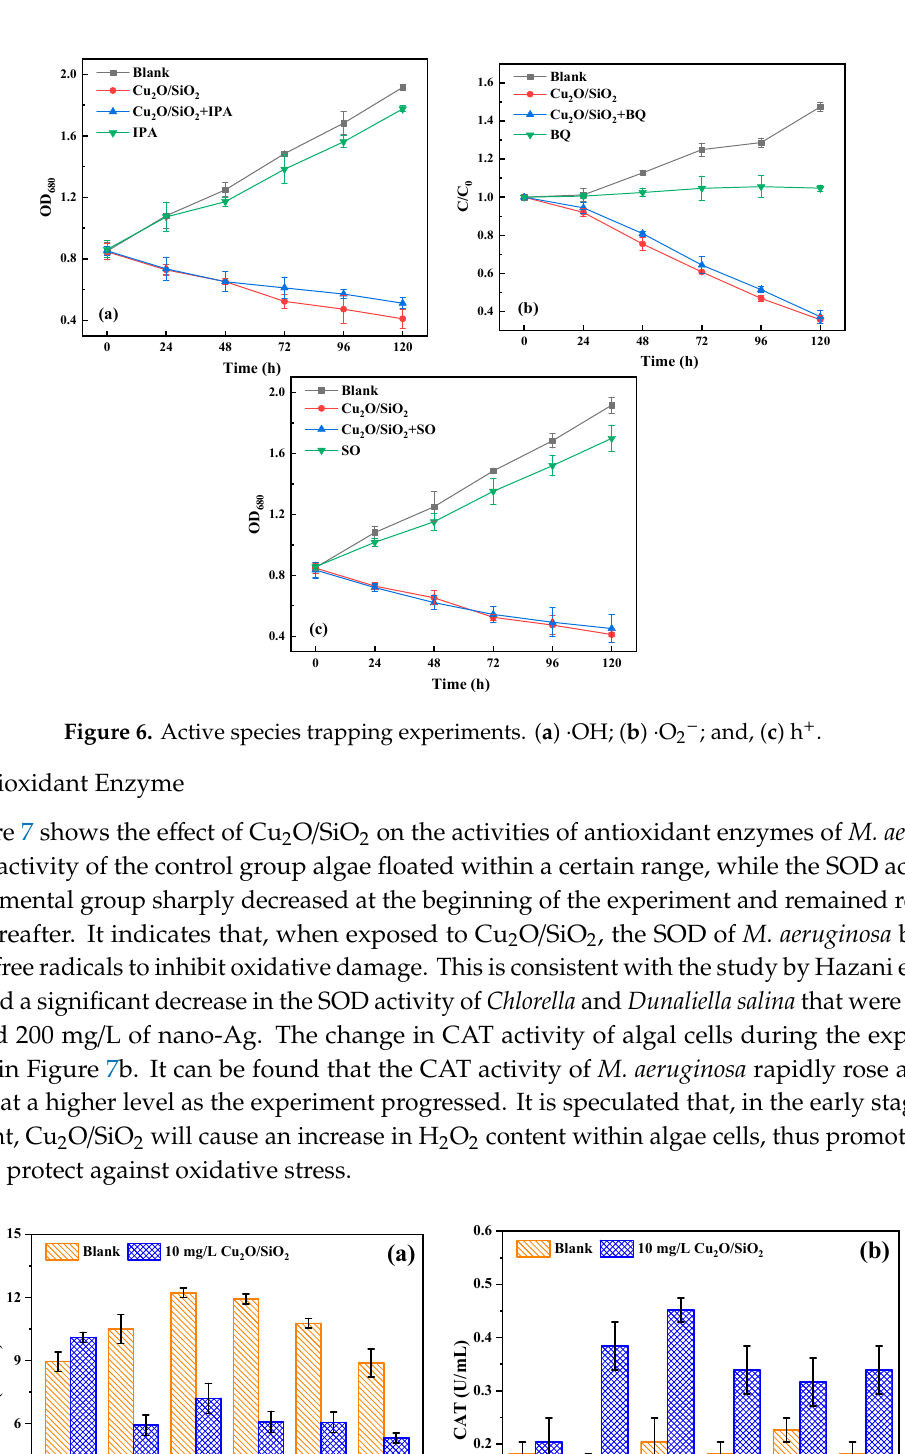
Figure 7. Changes of ( a ) superoxide dismutase (SOD) and ( b ) catalase (CAT) activities during algae removal by Cu 2 O / SiO 2